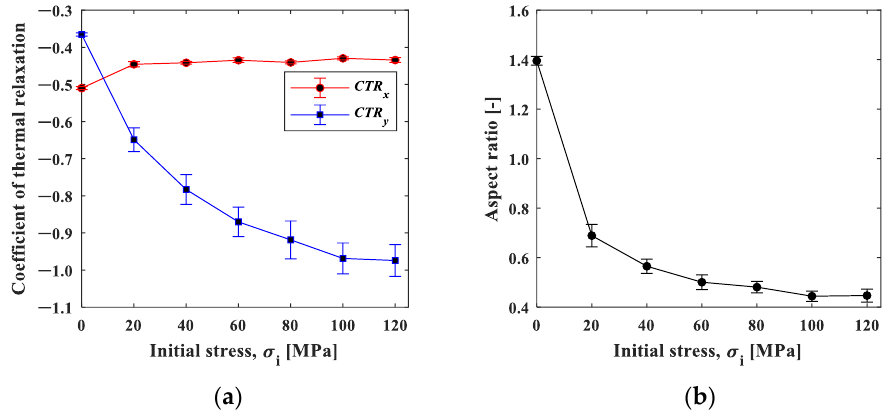
Figure 12. ( a ) CSR – initial stress curve plot; and ( b ) aspect ratio of CSR x /CSR y .